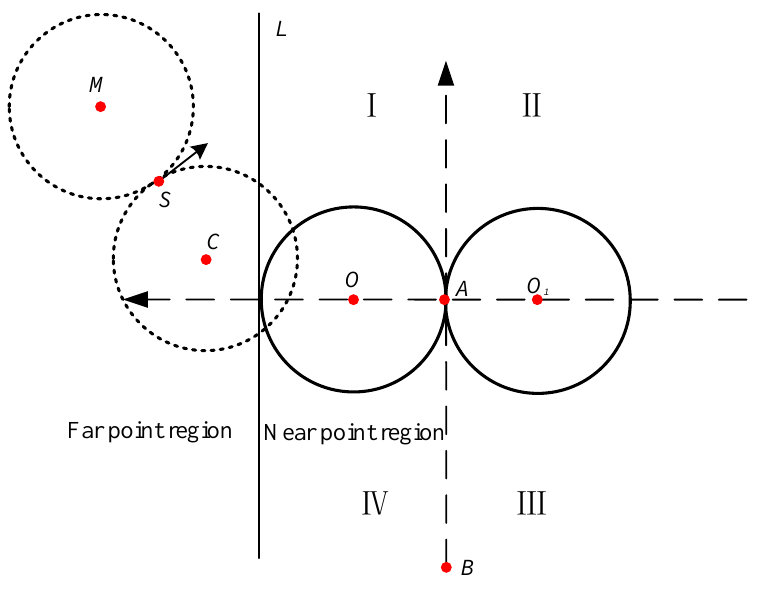
Figure 4. Redistribution of the navigable area. Circle C : The vessel rotates clockwise, while the rotating radius is R . That is, the starboard side of the ship turns to circle C . Its coordinate is ( x C , y C ) . Circle M : The vessel rotates anticlockwise, while the rotating radius is R . That is, the port side of the ship turns to circle M . Its coordinate is ( x M , y M ) . Circle O : The circle on the left of survey line AB in the new coordinate system and the radius of it is R . Its coordinate is ( x O , y O ) . Circle O 1 : The circle on the right of survey line AB in the new coordinate system and ) . the radius of it is R . Its coordinate is ( x O , y O 1 1 Line L : Line L and line AB are parallel. The distance between line L and survey line AB is 2 R . Line L is used to distinguish near and far points due to the necessity of reallocating navigable